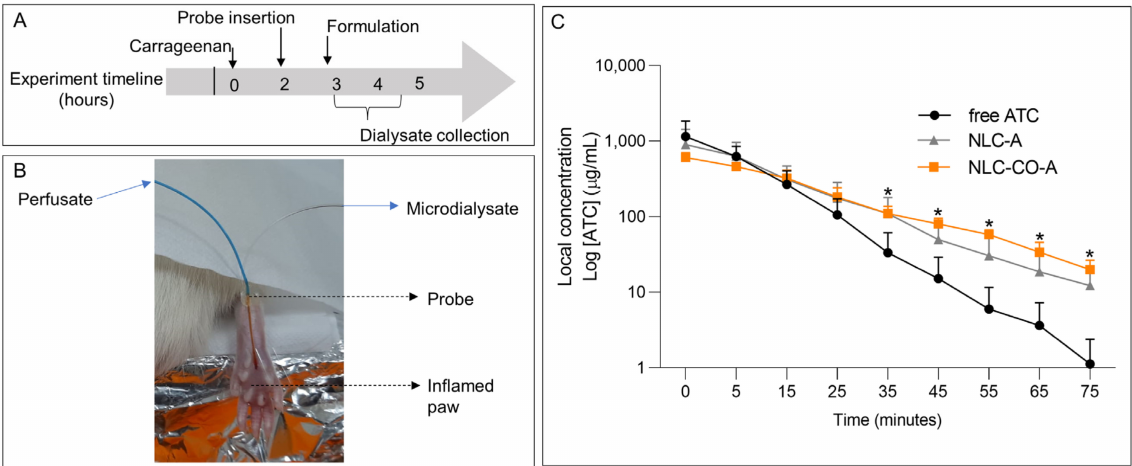
Figure 5. Pharmacokinetic study. ( A ) Experimental timeline. ( B ) Photo of the microdialysis probe inserted into the animal’s inflamed paw. ( C ) Local unbound articaine concentration (log [ATC]) in inflamed tissue over the time. * = statistically significant difference in relation to the free ATC group (ANOVA with post hoc Tukey’s multiple comparisons test; p < 0.05).